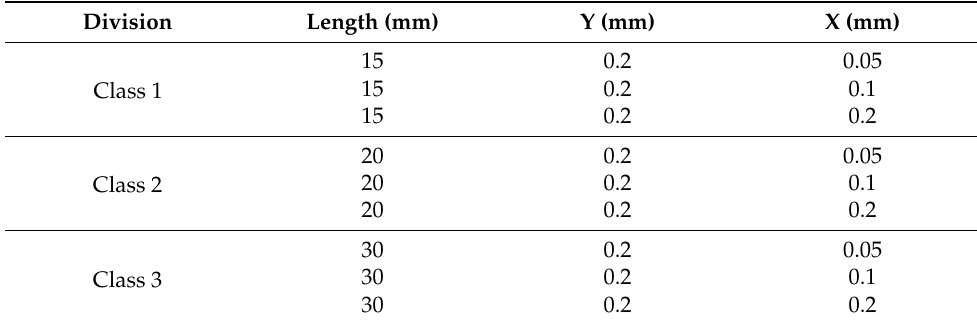
Table 5. Properties of model materials.